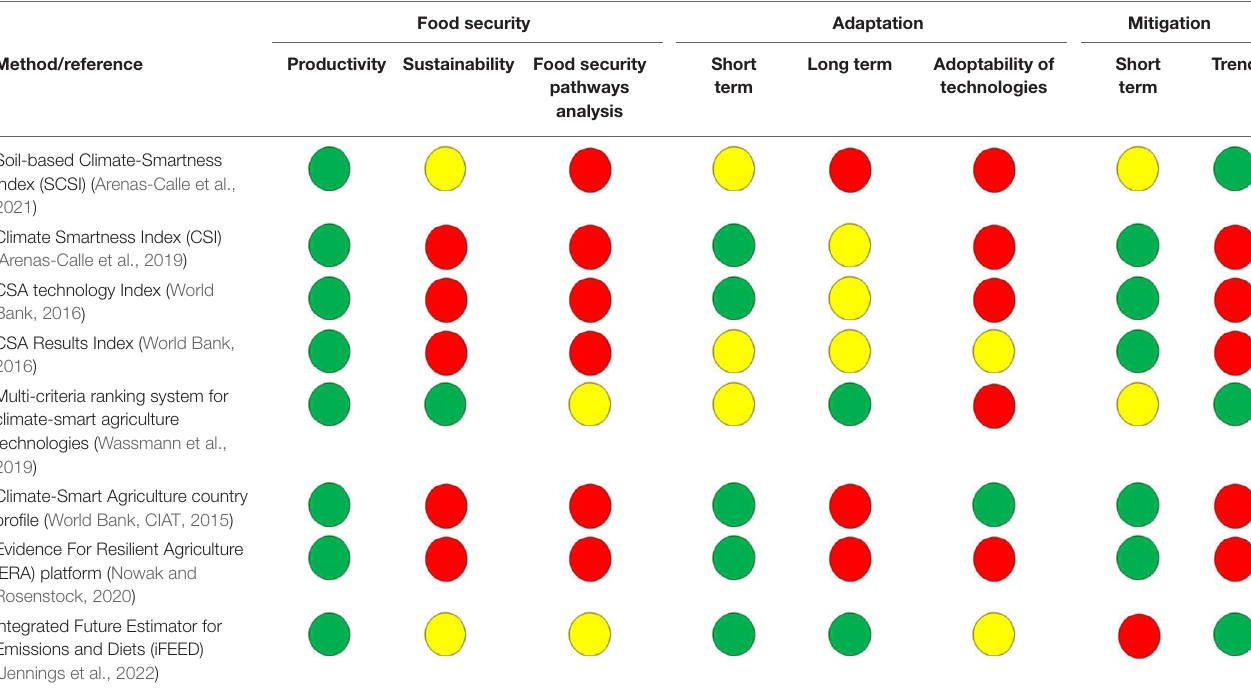
TABLE 1 | Summary of recent CSA assessment